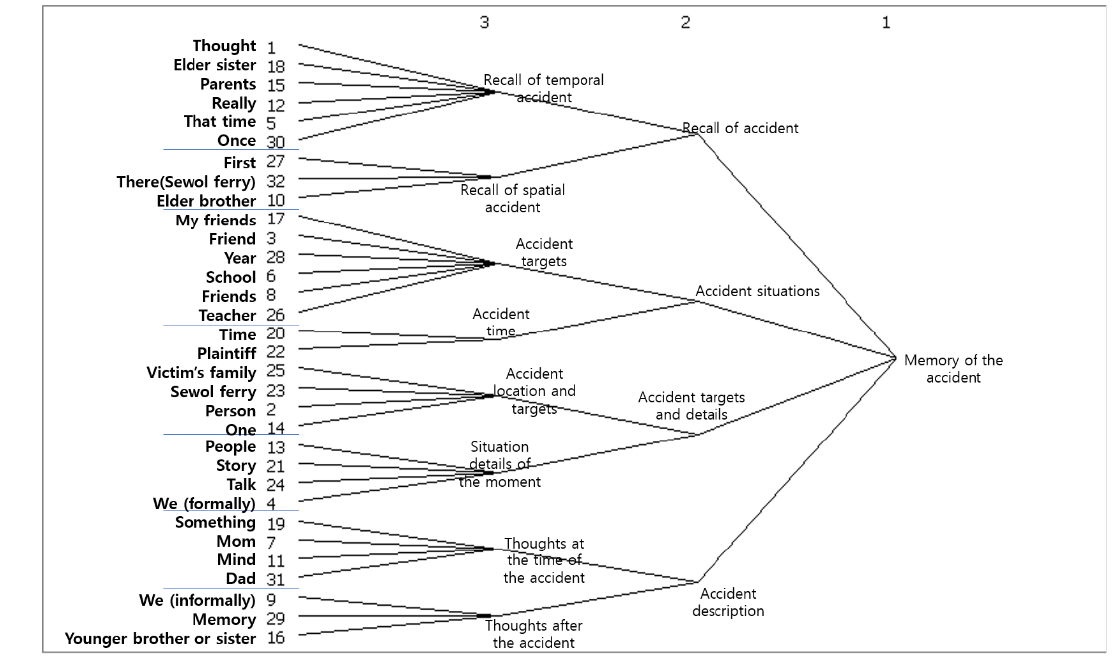
Figure 1. Similar word clusters and meanings of survivors.